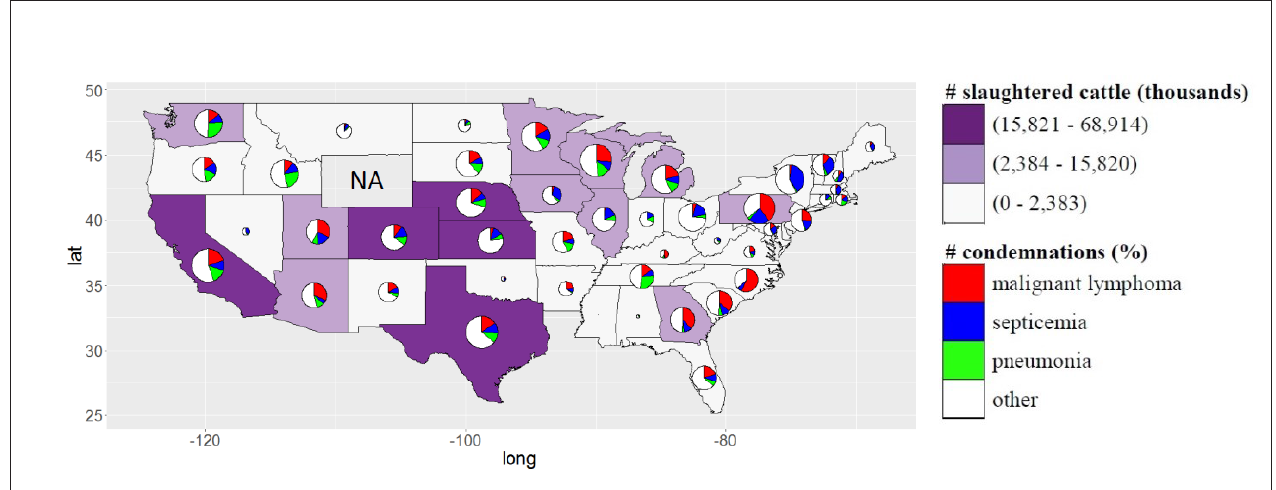
FigUre 2 | Number of the slaughtered cattle per state from Jan-2005 to Dec-2014 based on the 70, 90 and 100% percentile. The pie chart represents the percentage of the condemnation due to malignant lymphoma, septicaemia and pneumonia and other reasons of condemnation (red, blue, green and white, respectively). The size of the pie chart is computed as: log(number of condemnation carcasses)/10. NA = data not available. The accessible and dynamic version of this map is available in Disease BioPortal